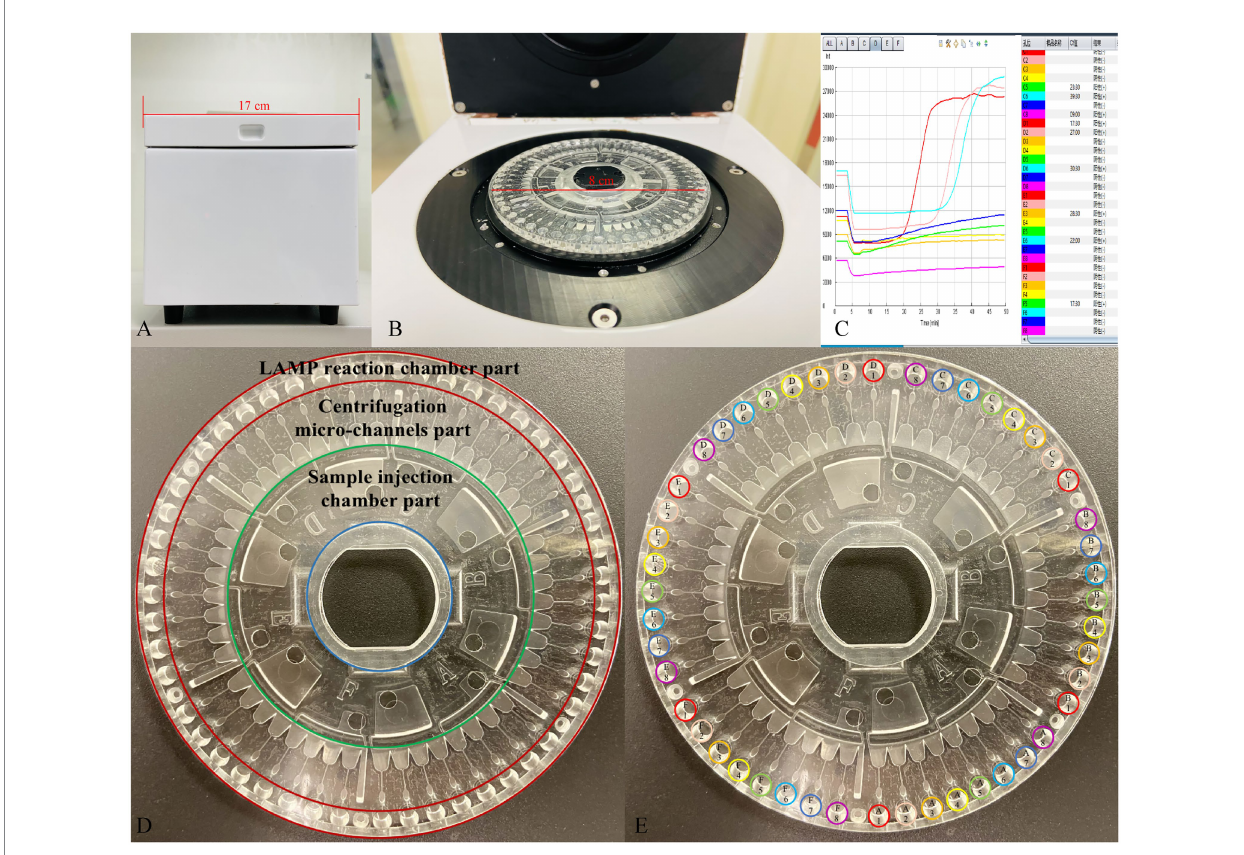
FIGURE 2 The developed centrifugal disk system, real-time detection instrument, and representative real-time amplification curves. (A,B) Photograph of a detection instrument. (C) Real-time amplification curves. (D) Simple composition of the centrifugal disk system. (E) The preload buffer and primers order of centrifugal disk. A1/D1: Eco; A2/D2: Kpn; A3/D3: Aba; A4/D4: Pae; A5/D5: Sau; A6/D6: Pae; A7/D7: Ecl; A8/D8: Efa; B1/E1: Efm; B2/E2: C. albicans ; B3/E3: SHV; B4/E4: TEM; B5/E5: CTX-M-1 Group; B6/E6: CTX-M-9 Group; B7/E7: KPC; B8/E8: NDM; C1/F1: IMP; C2/F2: OXA-23; C3/F3: OXA-24; C4/F4: OXA-48; C5/F5: DHA; C6/F6: CMY; C7/F7: mecA; C8/F8: